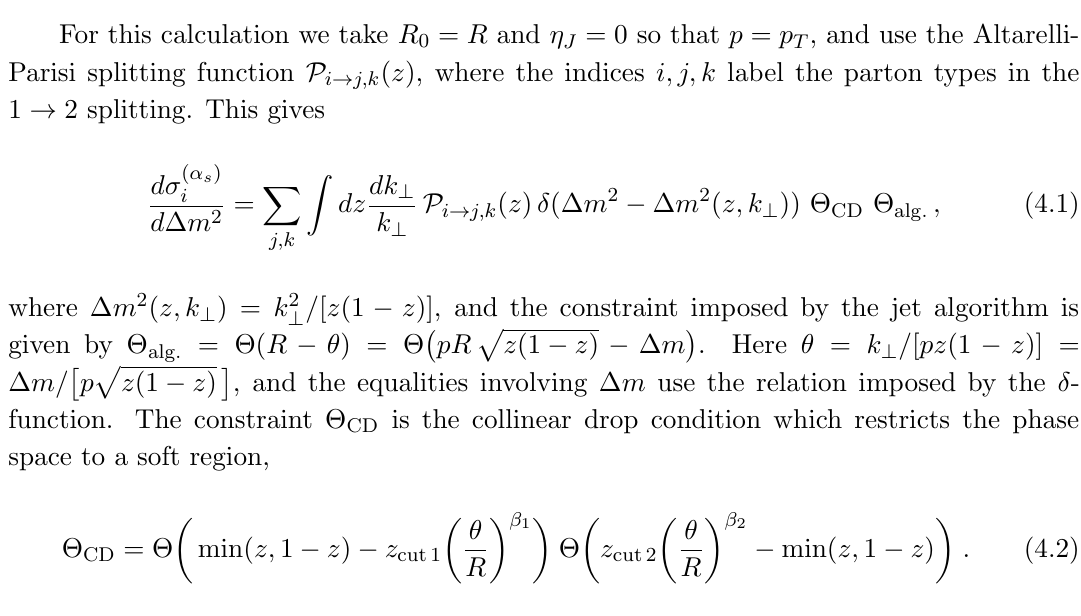
For this calculation we take R